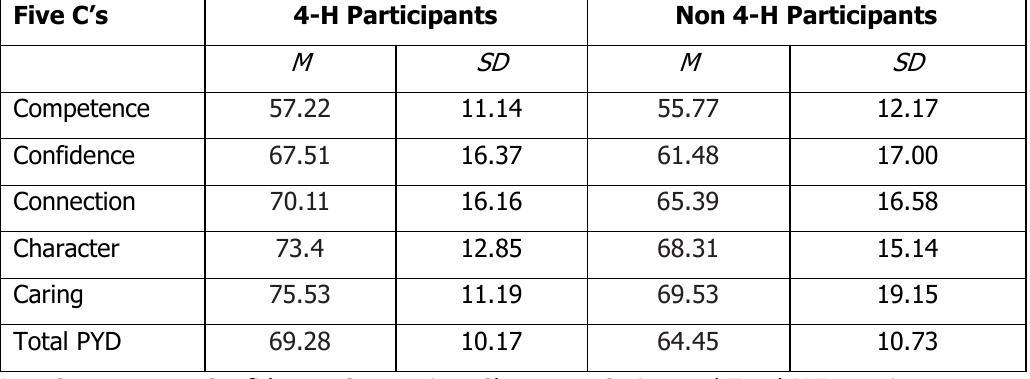
Means and Standard Deviations for Five C’s Between 4-H and Non-4-H Participants